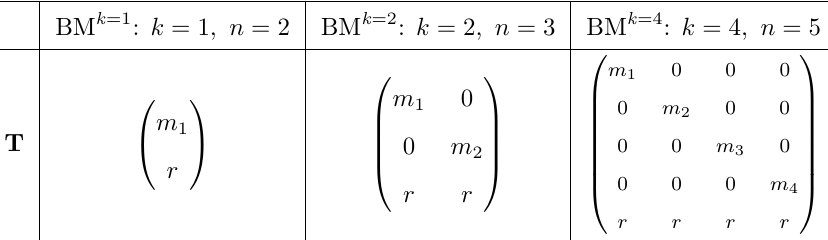
Table 6: Illustration of matrix T over F n × k